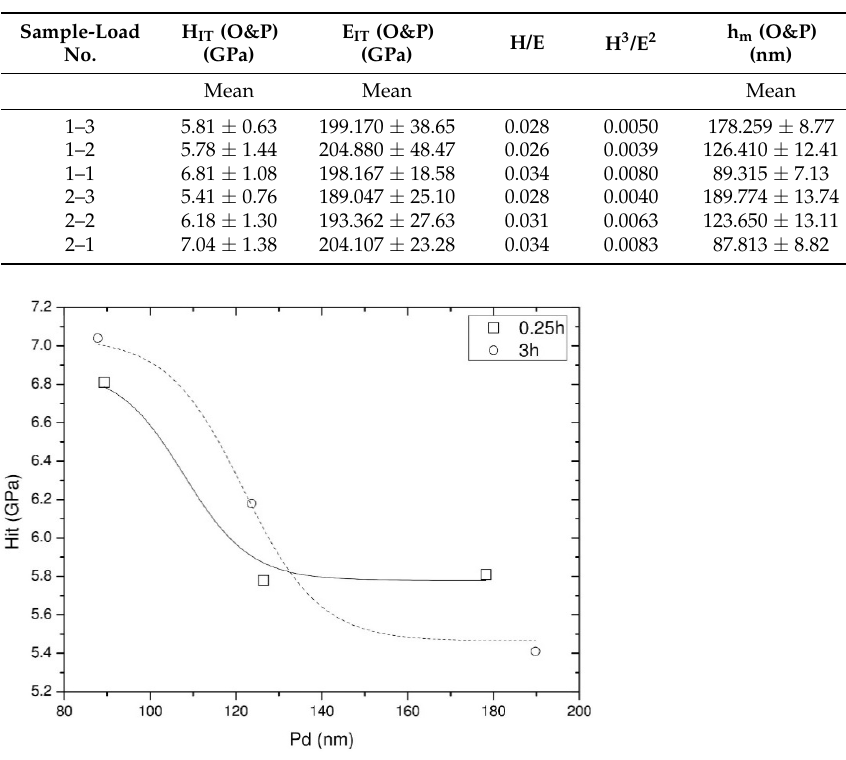
Table 3. Surface mechanical characteristics as a result of nanoindentation analysis.